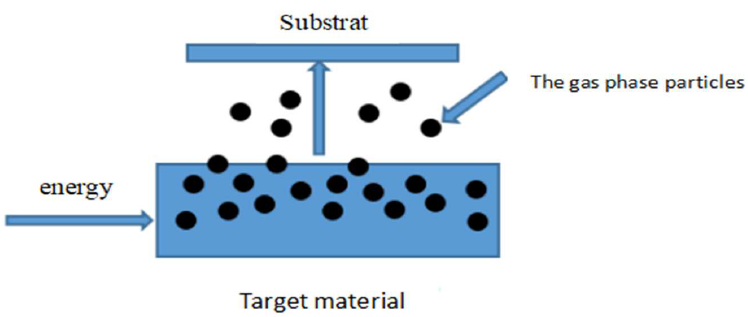
Figure 20. Schematic diagram of PVD